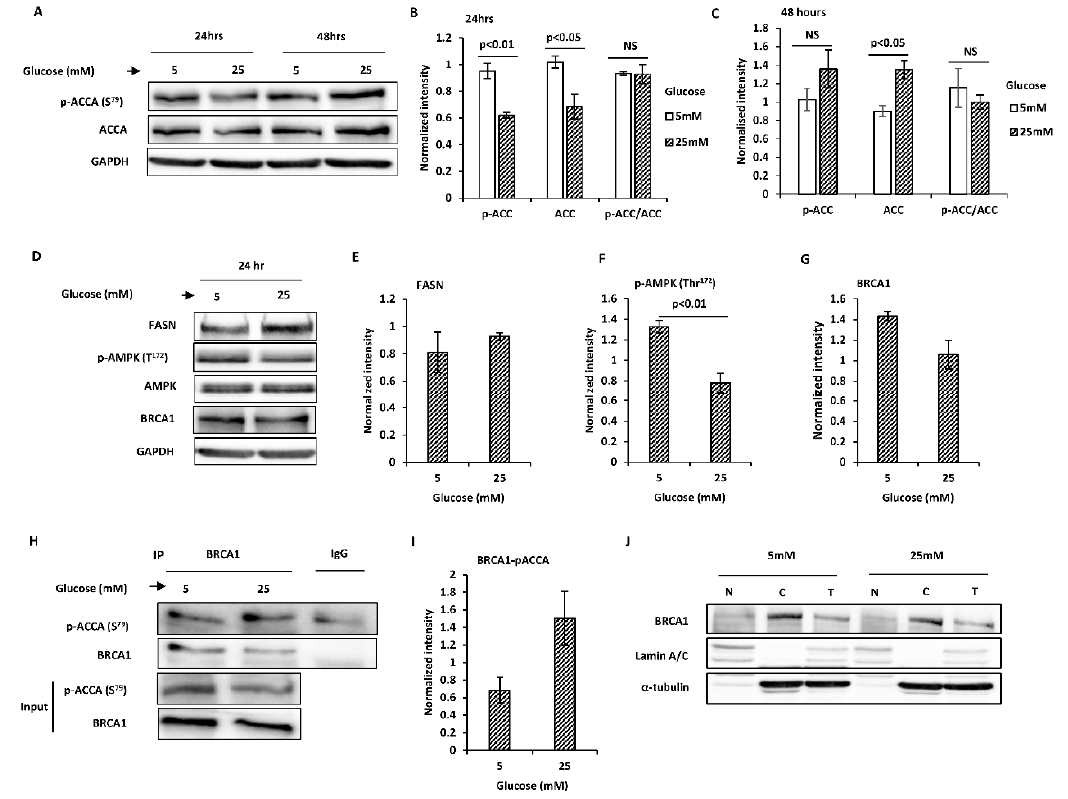
Figure 2. High glucose regulates key lipogenic proteins by glucose in T47D breast cancer cells. Cells were exposed to normal and high glucose for 24 and 48 h and whole cell lysates were subjected to Western blot analysis. ( A ) Representative blots of total acetyl CoA carboxylase (ACCA) and p-ACCA (S 79 ) are shown. ( B , C ) Densitometry analysis of total ACCA normalised to glyceraldehyde 3-phosphate dehydrogenase (GAPDH) and p-ACCA (S 79 ) normalised to both GAPDH and total ACCA. ( D ) Representative blots of fatty acid synthase (FASN), total AMP-activated protein kinase (AMPK), p-AMPK (Thr 172 ) and breast cancer 1, early onset (BRCA1) are shown. ( E – G ) Densitometry analysis of p-AMPK (Thr 172 ) normalised to total AMPK and FASN and BRCA1 normalised to GAPDH. ( H ) Lysates from cells exposed to normal and high glucose for 24 h were subjected to immunoprecipitation with 2 µ g anti-BRCA1 antibody or negative control IgG, followed by Western blotting using BRCA1 and p-ACCA (S 79 ) antibodies. Input represent lysates not used for immunoprecipitation. ( I ) The graph shows signal of precipitated p-ACCA (S 79 ) normalised to BRCA1. ( J ) Western blotting of cytoplasmic and nuclear fractions from cells exposed to low and high glucose for 24 h. Lamin A / C and α -tubulin were used as nuclear and cytoplasmic markers, respectively. All results shown are representative of three independent experiments and the graphs represent mean ± SEM. Independent samples t -test was used to compare means of 2 groups.